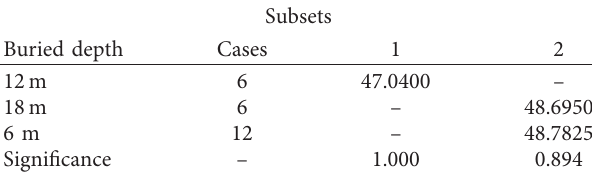
Table 6: Significance analysis of the tunnel buried